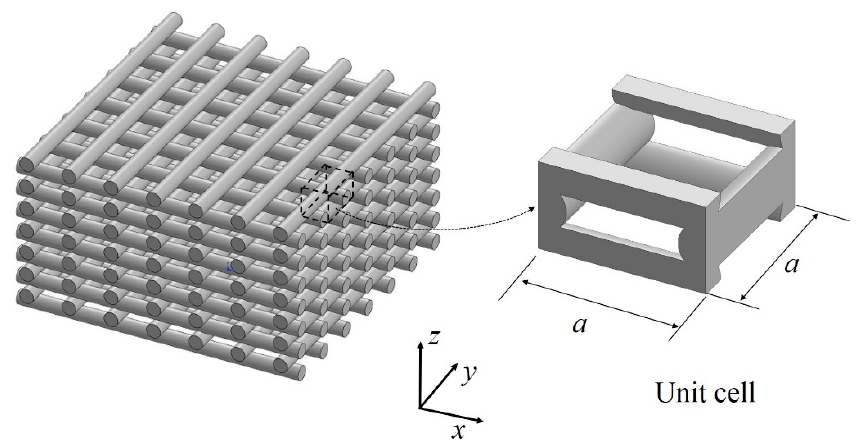
Figure 7. Schematic representation of the FFF raster lattice structure. Rasters are represented with cylinders, and the unit cell of such lattice is shown as an extraction from the lattice.